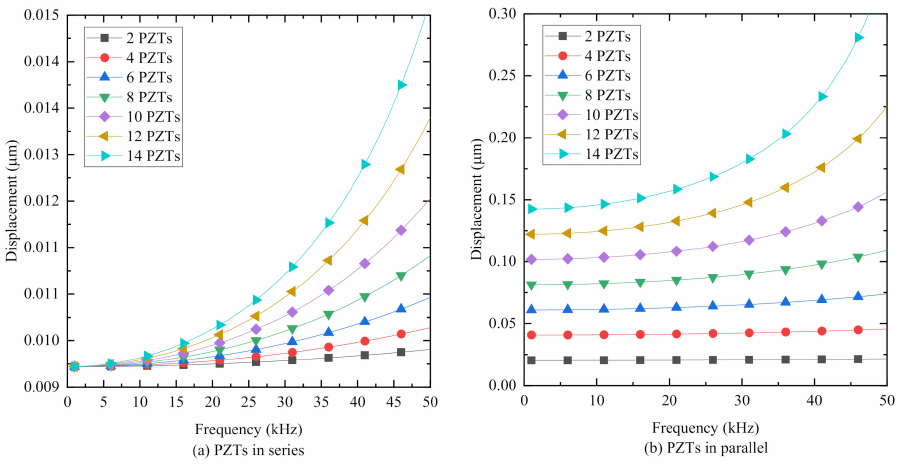
Figure 9. The displace at z = h c1 versus the number of the PZT wafers n: ( a ) PZTs in series connection; and ( b ) PZTs in parallel